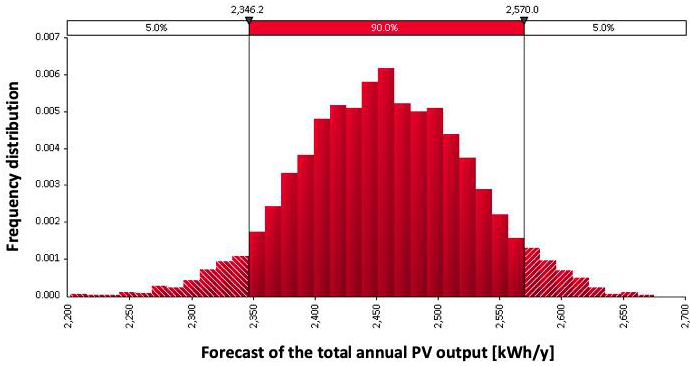
Figure 7. Forecast of the total annual energy produced by the PV array.